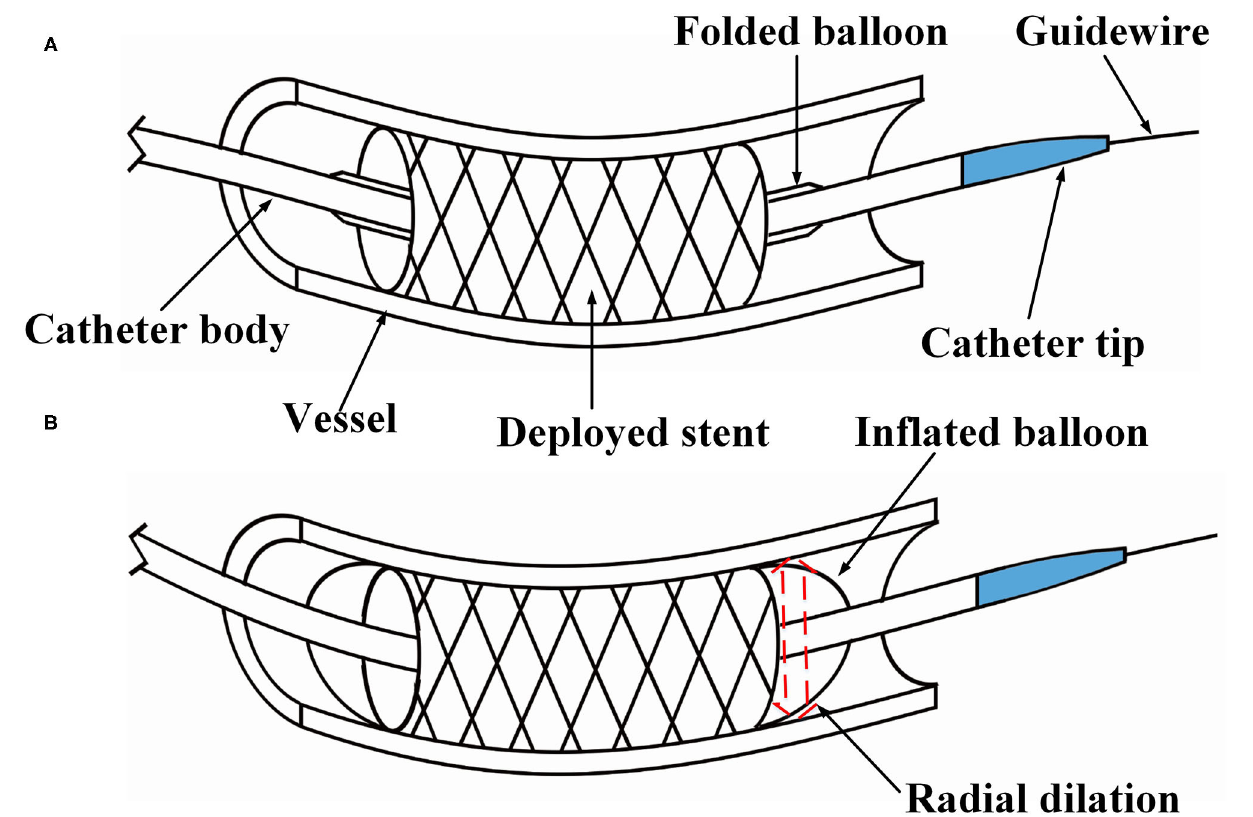
FIGURE 1 | Illustration of percutaneous coronary intervention. (A) The stent is placed at the narrow section of the vessel, and (B) under in-stent dilation during the post-dilation